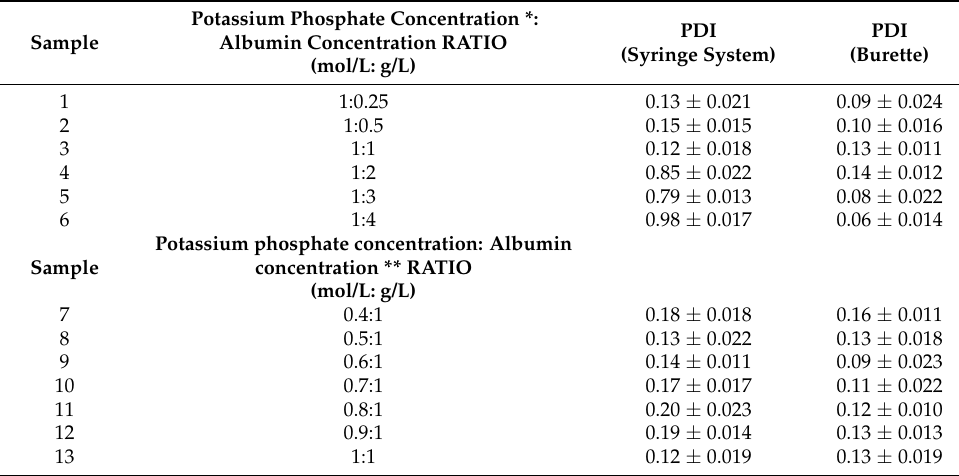
Figure 7. Results of DLS analysis of albumin particles obtained using various K 3 PO 4 concentrations via a syringe system ( A ) and using a burette ( B ) ( n = 3, n —Number of repetitions). Below in Table 3. values of the polydispersity index (PDI) of all prepared samples are listed. Table 3. PDI values of prepared samples.